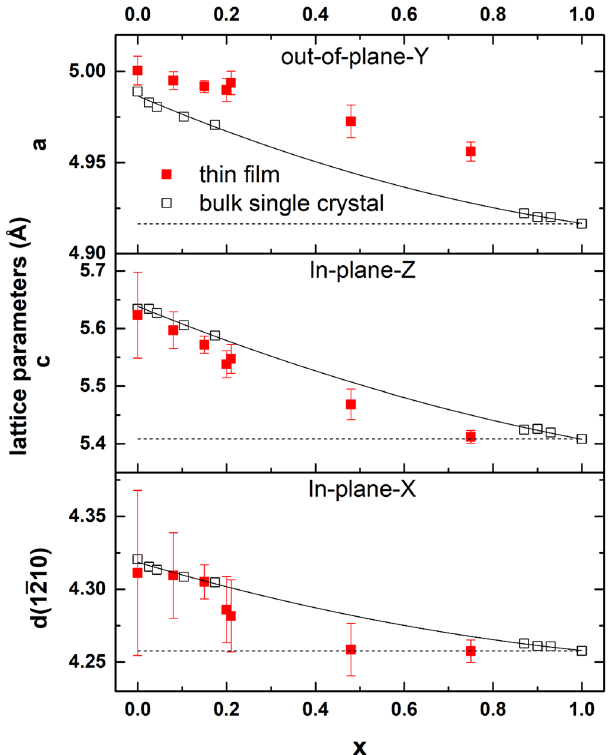
Figure 8. Evolution of lattice parameters of the Si x Ge 1 − x O 2 solid solution grown on Y-cut quartz substrates. The thin film data (solid squares) are obtained from Fig. 7 (also collected in Table S3). The data from bulk single crystal are obtained from Refs. 17,25 . The solid lines are the second-order polynomial fitting of the bulk data, as described in the Ref. 17 . Dash lines are the lattice parameters of the substrates. The thin film lattice in the [0001] strongly subjected to the stress from the substrate, being nearly fully strained for x = 0.48. The compressive strain in the [ 1 ¯ 210 ] direction is mainly accommodated by the expansion in out-of-plane